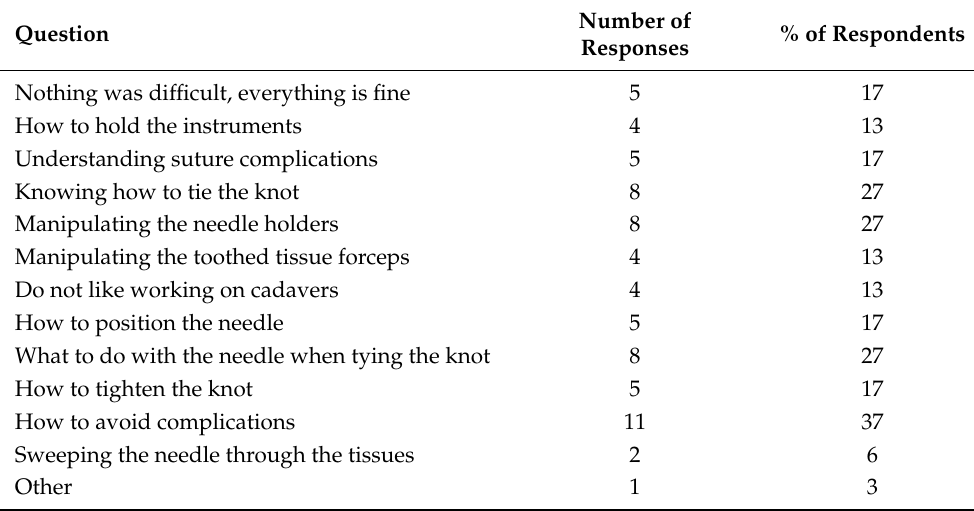
Table 4. Aspects of the Suturing Course that students ( n = 30) found